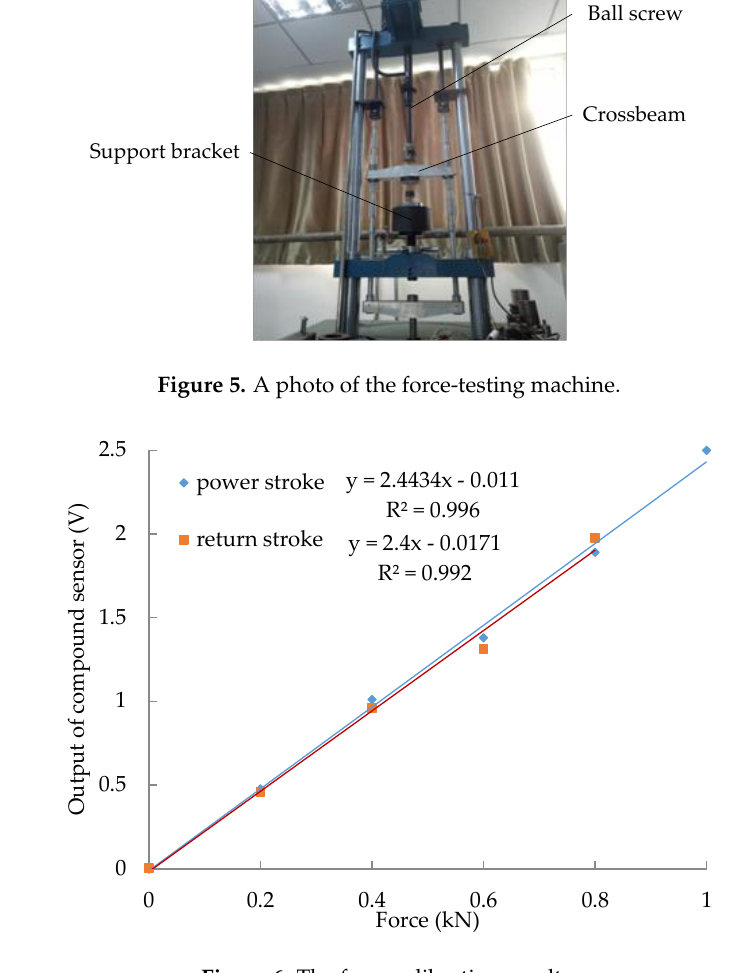
Figure 6. The force calibration results.